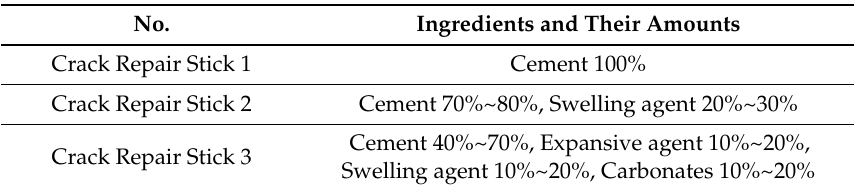
Table 1. Details of the crack repair